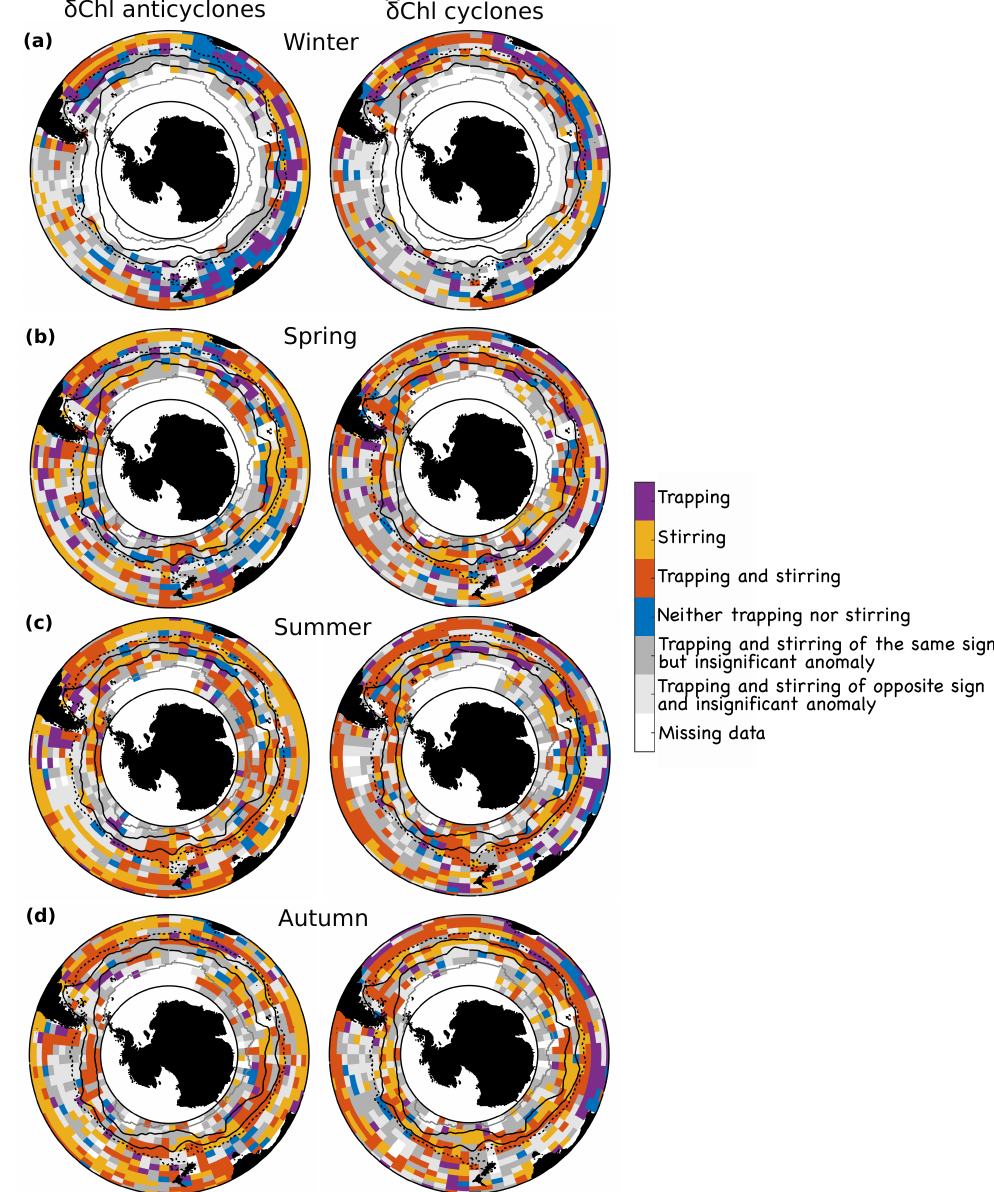
Figure 8. Maps of the distribution of the processes likely controlling the chlorophyll anomalies ( δ Chl) for austral (a) winter, (b) spring, (c) summer and (d) autumn for anticyclones (left) and cyclones (right). The method and legend is the same as used in Fig. 7. Otherwise the same as Fig.